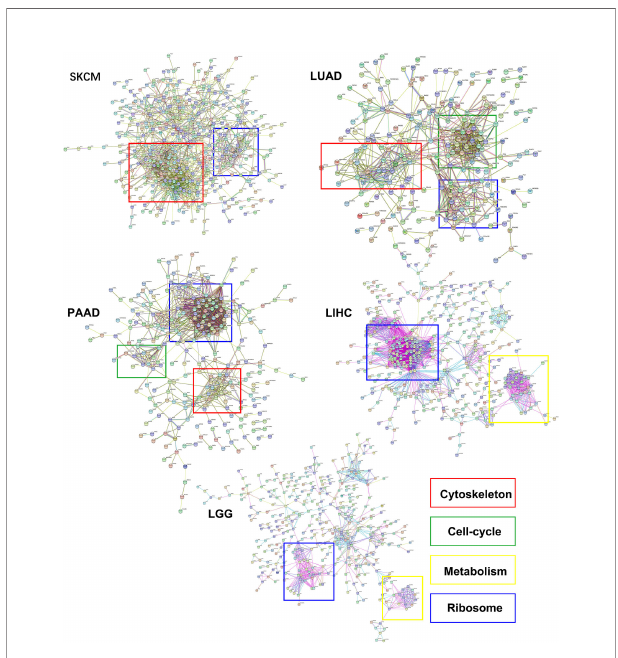
FIGURE 5 | The protein-protein interaction clustering of differentially expressed genes while eIF6 was up-regulated in cancers. The signi fi cantly up-regulated genes in the eIF6 altered group were clustered according to protein interactions. The ribosomal proteins formed clusters in all fi ve cancers. The cytoskeletal proteins were clustered in SKCM, LUAD, and PAAD, while the cell-cycle and metabolism proteins were clustered in PAAD and LUAD and LIHC cancers,